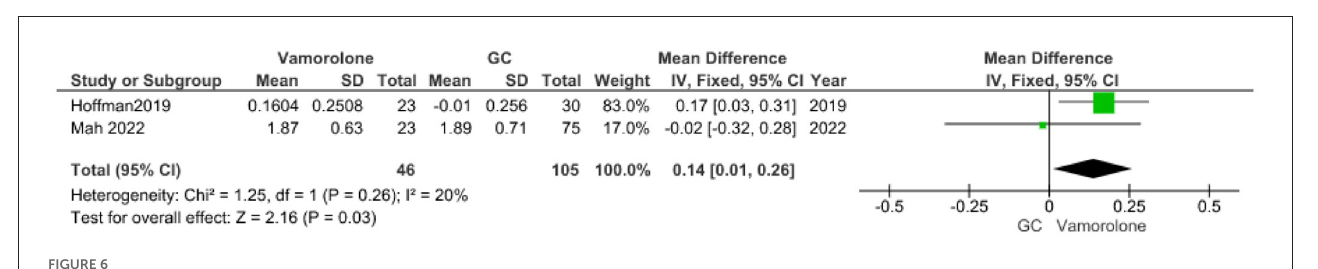
FIGURE6 TTRW outcome vamorolone vs.